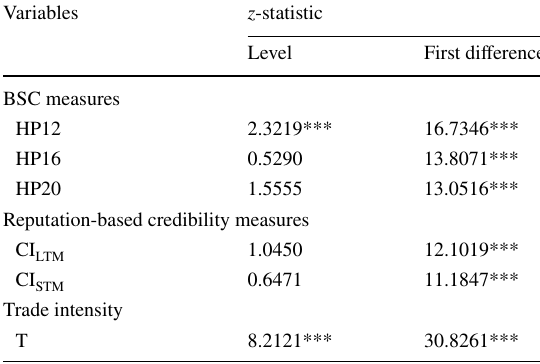
Table 3 Im, Pesaran and Shin (2003) unit root test. Source : Own elaboration